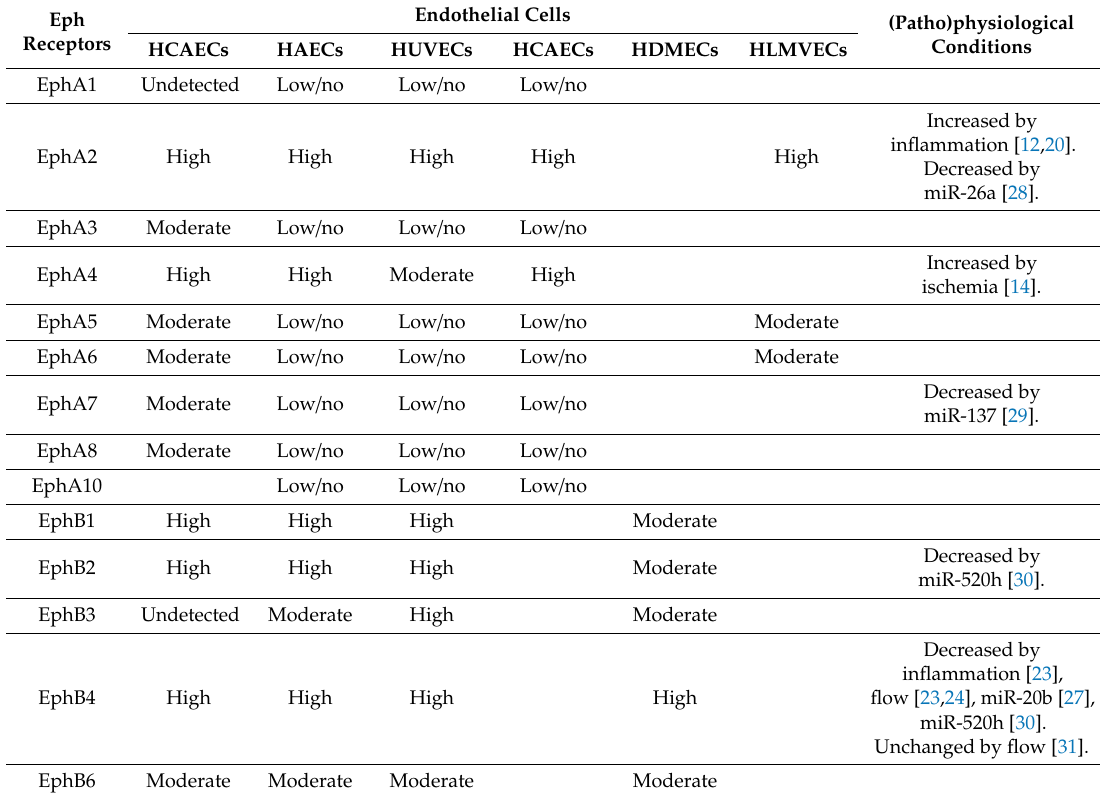
Table 2. Eph receptor expression in endothelial